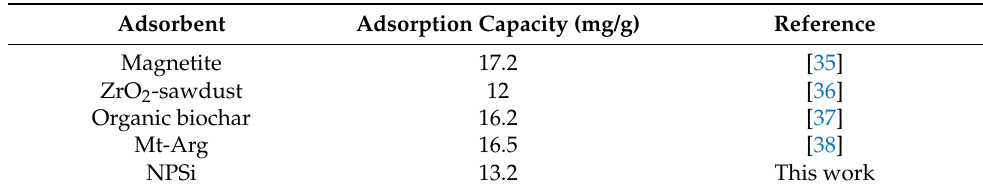
Table 2. As(V) adsorption capacities for different adsorbents.